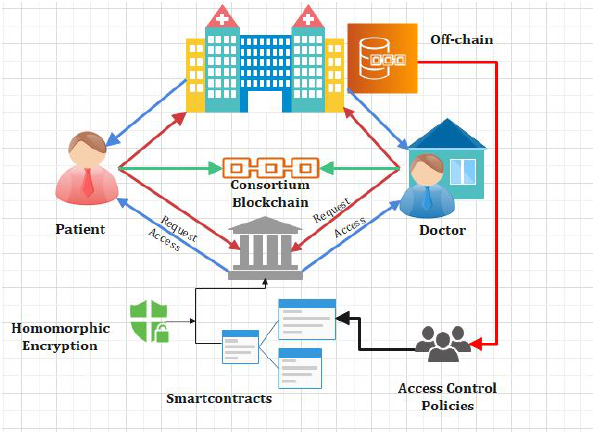
Figure 9. Keyword Search based Framework for EHR System.